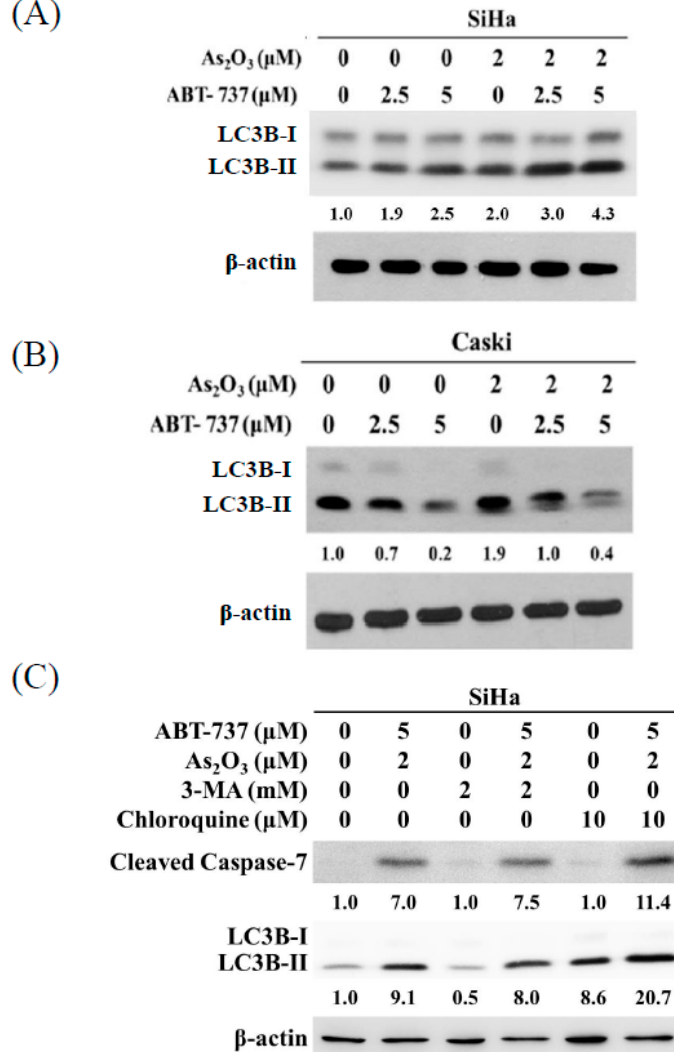
Figure 6. E ff ects of ABT-737 and As 2 O 3 on autophagy induction in cervical cancer cells. ( A ) SiHa and ( B ) Caski cells (4 × 10 5 cells / 6 cm dish) were co-treated with ABT-737 and As 2 O 3 for 48 h. LC3B was detected by Western blot. β -actin was as a loading control. The relative ratio of LC3B II/LC3B I was shown. ( C ) After pretreatment of 3-MA for 1 h, ABT-737, As 2 O 3 , and chloroquine were treated for 48 h. LC3B and cleaved caspase-7 were detected by Western blot. β -actin was as a loading control. The relative ratio of LC3B-II/LC3B-I and cleaved caspase-7/ β -actin are shown.